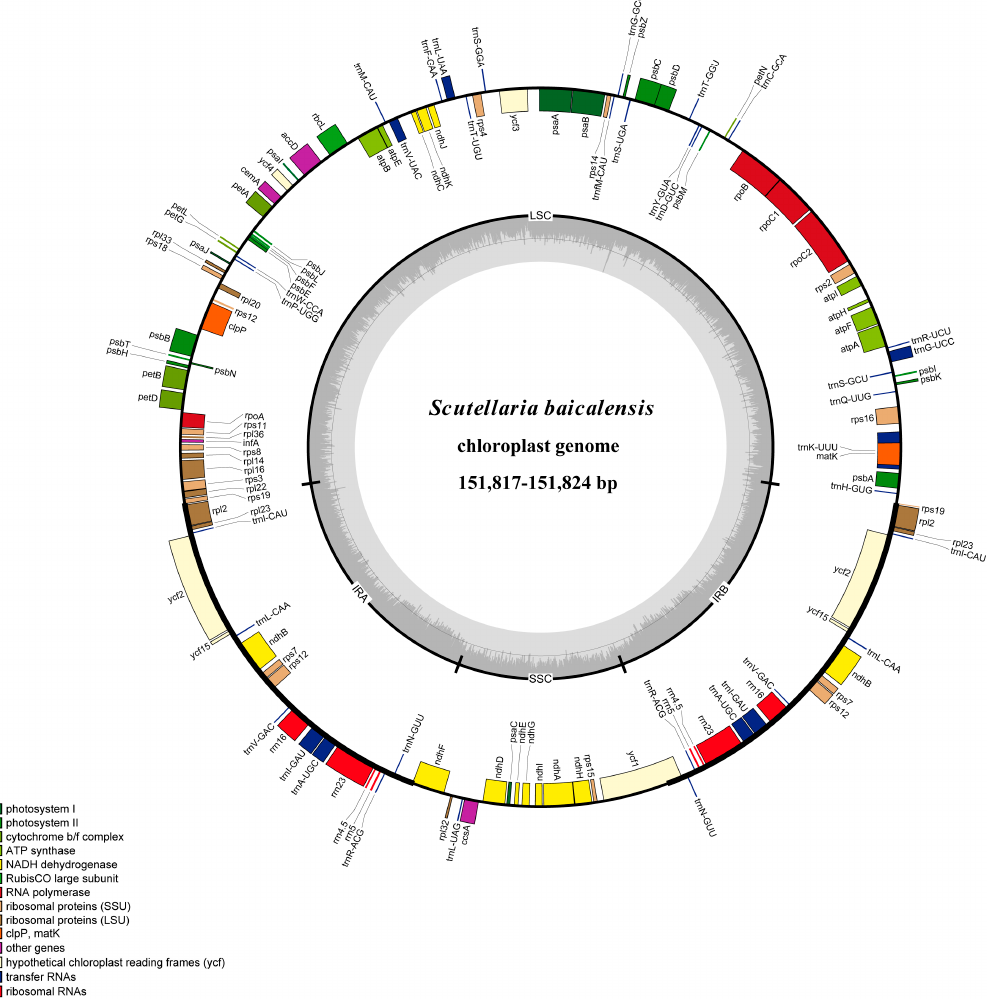
Figure 1. Chloroplast genome map of Scutellaria baicalensis . The genes drawn outside of the circle